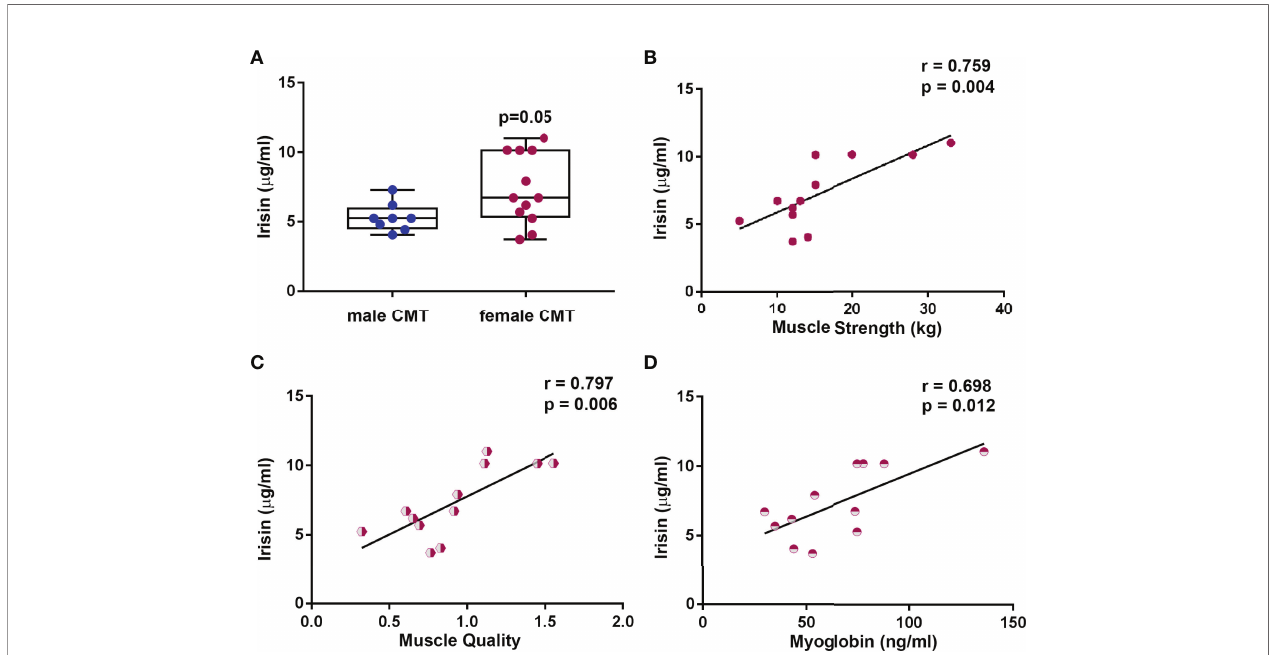
FIGURE 5 | Circulating Irisin levels are higher in female CMT patients (N = 12) than in male (N = 8) (A) . Data are presented as box-and-whisker plots with median and interquartile ranges, from max to min, with all data points shown. In female CMT patients, Irisin positively correlated with muscle strength (B) , muscle quality (C) , and myoglobin (D) . Linear regression, r and p values as